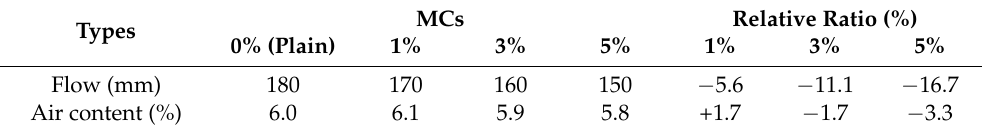
Table 5. Test results of flow and air content according to